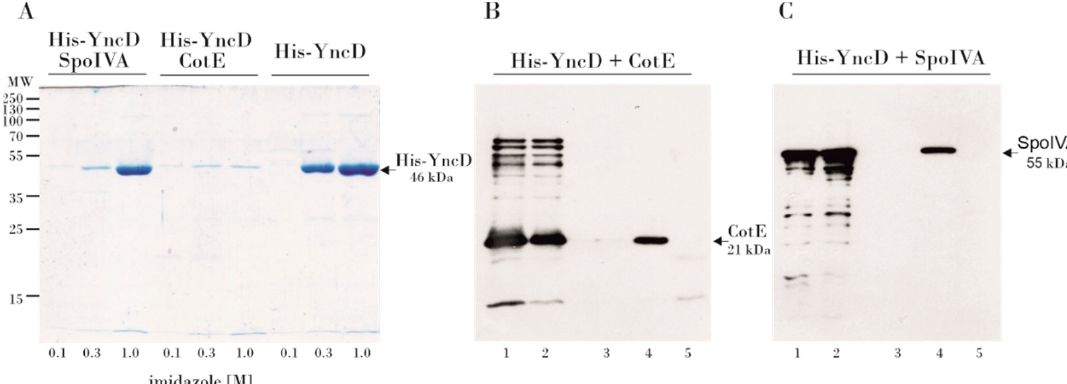
Figure 2. Pull-down analysis of the YncD interaction with morphogenetic proteins. ( A ) Sodium dodecyl sulfate-polyacrylamide gel electrophoresis (SDS-PAGE) gel of proteins co-expressed in Escherichia coli , loaded onto a HisTrap HP Ni-column and eluted with an imidazole step gradient. The imidazole concentration is shown in the figure. Lanes 1–3 contain fractions eluted after co-expression and co-purification of YncD+SpoIVA; lanes 4–6 contain fractions eluted after co-expression and co-purification of YncD+CotE; lanes 7–9 show fractions eluted after expression and purification of YncD alone. In all experiments we used the same volume of the same cell extract. ( B ) Western blot analysis of the YncD–CotE interaction. Proteins were probed with a polyclonal anti-CotE antibody. Lane 1–cell lysate with over-expressed, untagged CotE; lane 2–a mix of cell lysates with over-expressed CotE and His-tagged YncD; lane 3–negative control, elution from Ni-column, untagged CotE did not bind to the column; lane 4–CotE co-purified with His-tagged YncD; lane 5–His-tagged YncD does not provide a signal when using the anti-CotE antibody. ( C ) Western blot analysis of the YncD–SpoIVA interaction. Cell lysates with over-expressed proteins were mixed, loaded onto a HisTrap HP Ni-column and eluted with imidazole. Proteins were probed with a polyclonal anti-SpoIVA antibody. Lane 1–cell lysate with over-expressed SpoIVA; lane 2–mix of cell lysates with over-expressed SpoIVA and His-tagged YncD; lane 3–negative control, elution from Ni-column, untagged SpoIVA did not bind to the column; lane 4–SpoIVA co-purified with His-tagged YncD; lane 5–His-tagged YncD does not give a signal from an anti-SpoIVA antibody.